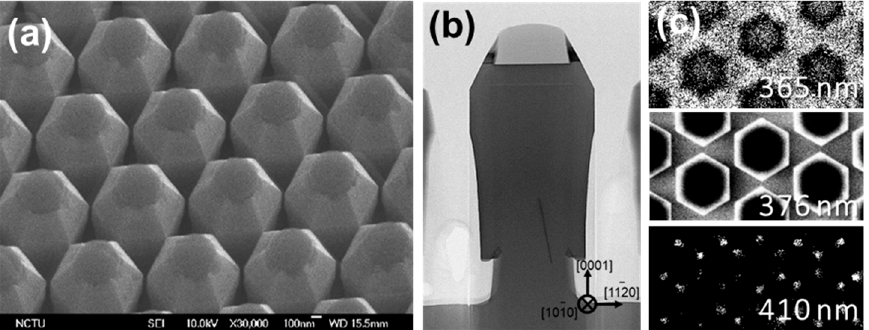
Figure 1. ( a ) The bird-view scanning electron microscopy; ( b ) cross-sectional transmission electron microscopy; ( c ) top view monochromatic cathodoluminescence images of the GaN-InGaN core-shell array.